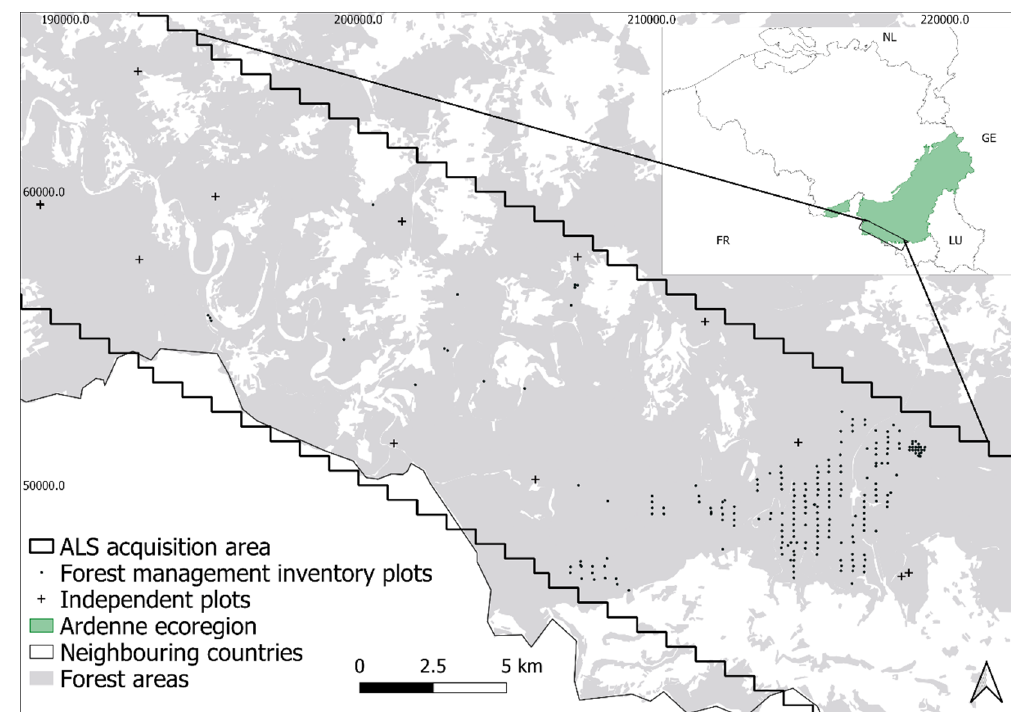
Figure 1. Study area in southern Belgium (Wallonia). Forest areas are in light grey. Black dots indicate forest management inventory (FMI) plots. Black crosses indicate independent plots. ALS, airborne laser scanning; FR, France; LU, Luxembourg; GE, Germany; NL, The Netherlands.